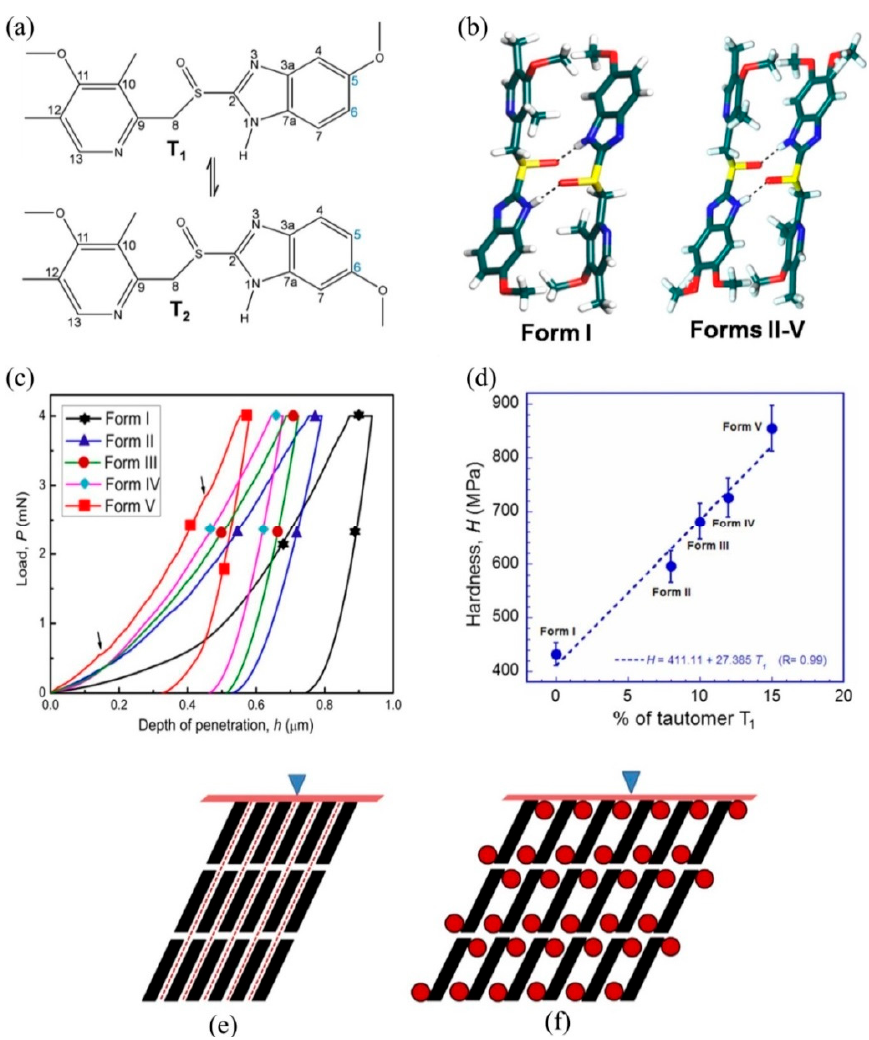
Figure 12. ( a ) Tautomeric forms of omeprazole. ( b ) All five forms of omeprazole contain centrosymmetric N - H···O=S dimers. Note the positioning of the 5- and 6-methoxy groups on the benzimidazole ring. ( c ) Representative P-h curves of all five forms of omeprazole. ( d ) The linear correlation between H and proportion of the 5-methoxy tautomer, T 1 in omeprazole polymorphs. ( e ) Schematic crystal packing of omeprazole form I ( a ) and forms II–V ( b ). The dimers of are depicted as solid parallelograms. The direction of indentation [001] is shown as a solid triangle. Slip planes of the form I are represented by red dotted lines. ( f ) Note that the methoxy groups are shown in solid red circles in forms II–V. (Reproduced with permission from American Chemical Society, Reference 92).